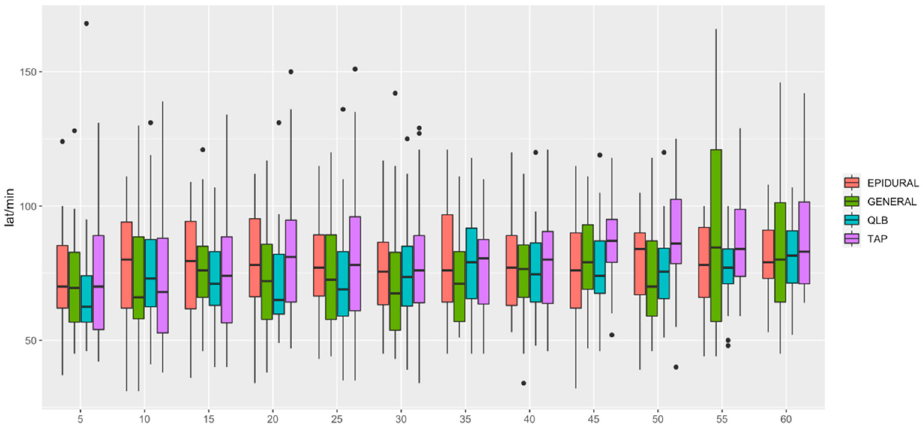
Figure 1. Graphic showing the different values of heart rate (HR) over time. A significant difference was found between General vs QLB and General vs TAP.